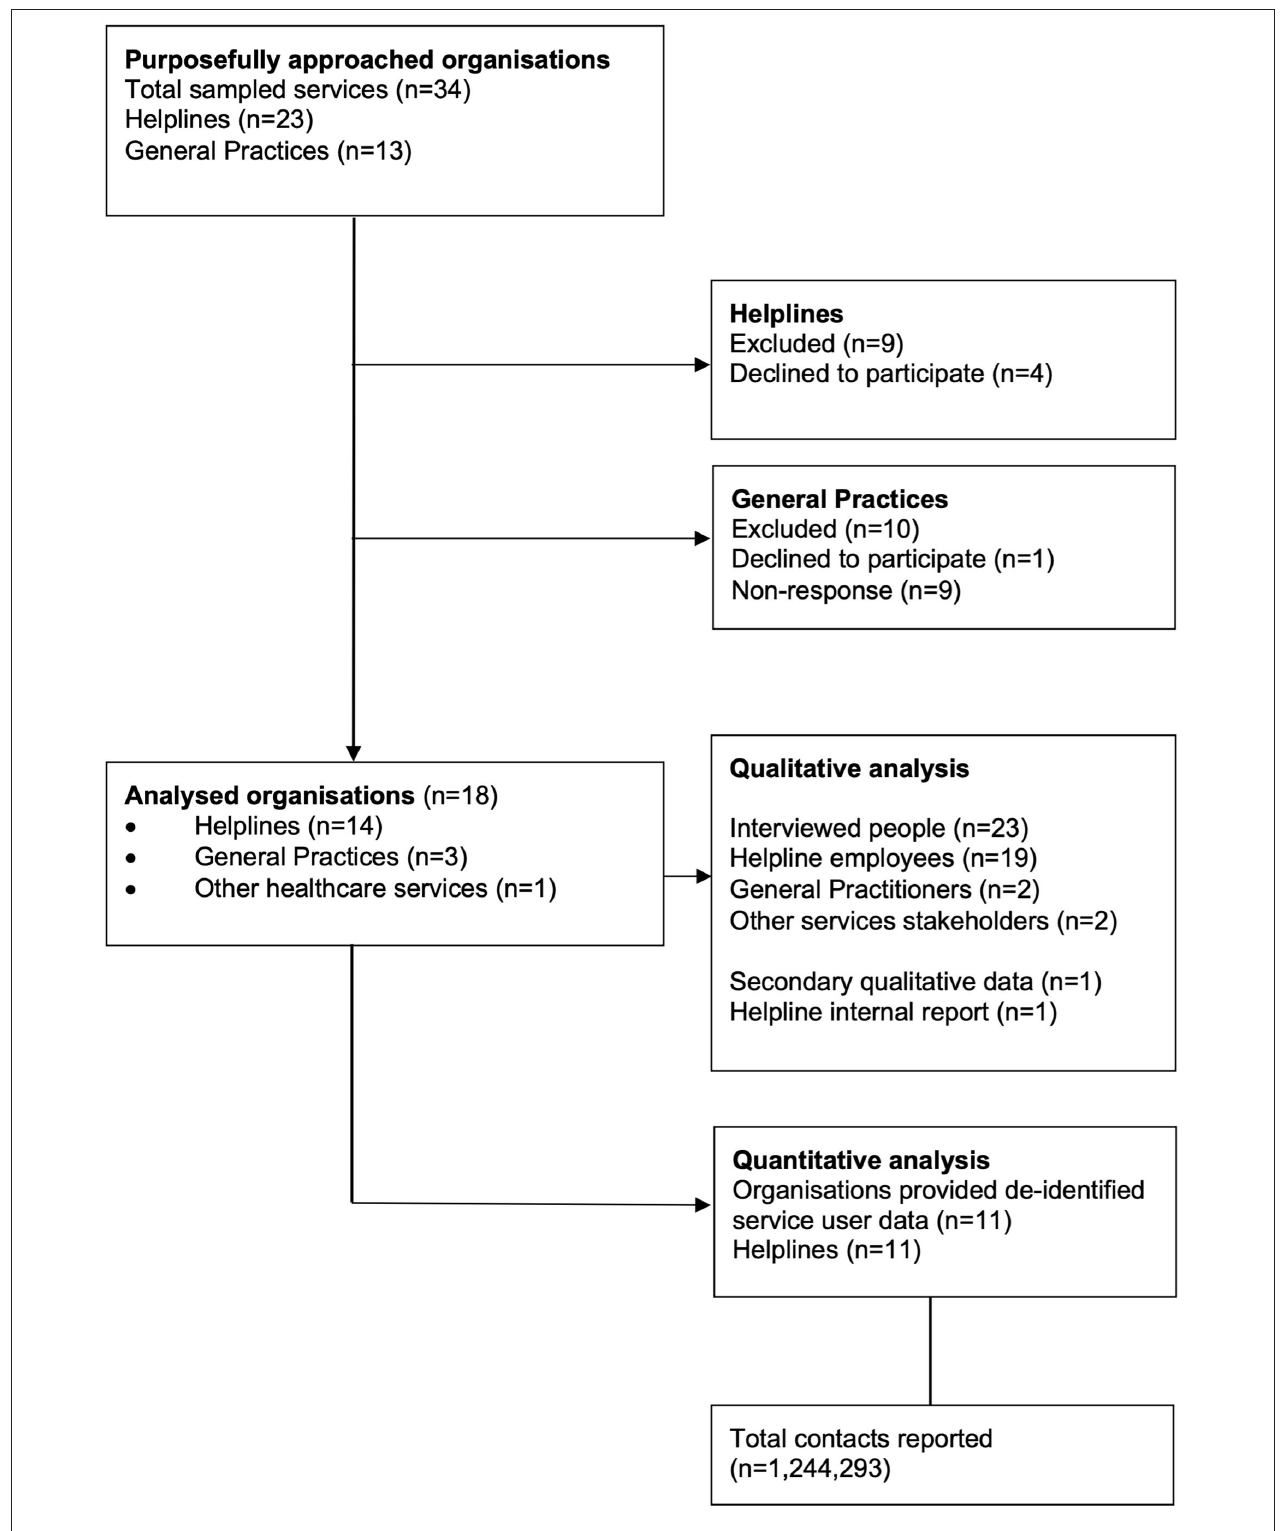
FIGURE 1 | Data collection flow